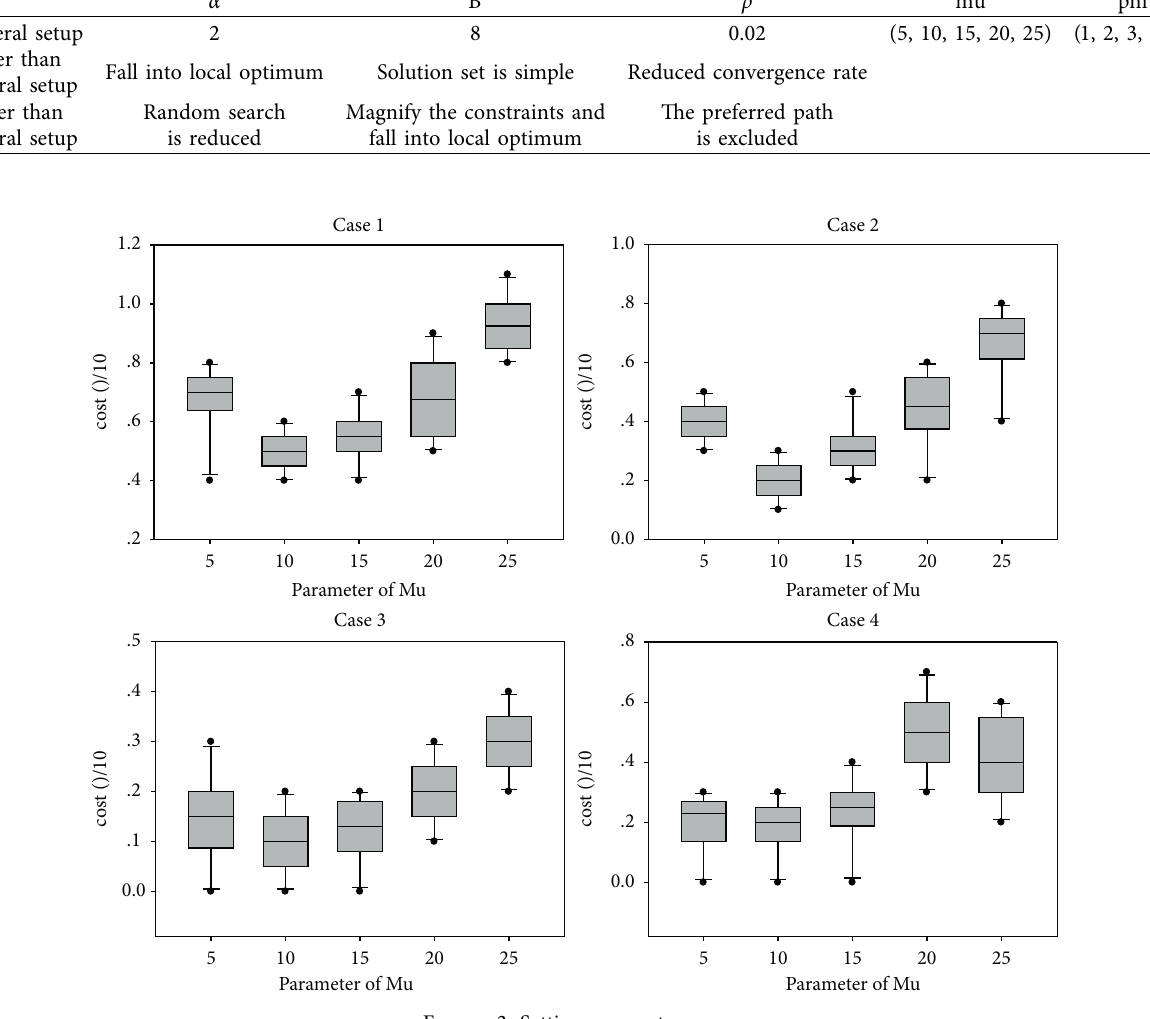
Figure 3: Setting parameter